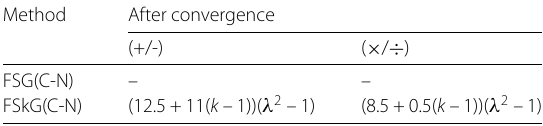
Table 2 Computational complexity analysis for FSG(C-N) and FSkG(C-N) methods after convergence